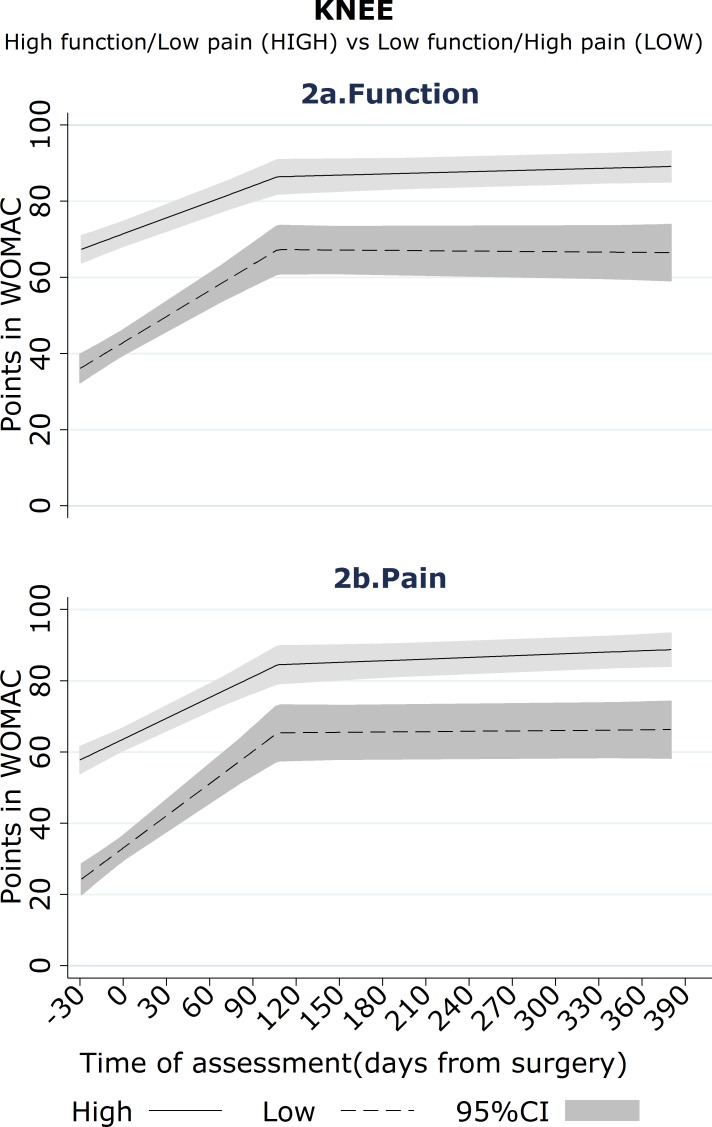
Knee -Mean trajectoriesa for WOMAC-pain and WOMAC-function (Unstandardized outcomes) by high vs. low pre-operative pain/functionb.A. The mean trajectories are derived from the fixed effects of linear mixed model stratified on high-low profile and regressing each outcome on the time of assessment parameterised as two linear splines. B. High/low function status defined on pre-operative WOMAC-function or -pain using their median scores (51 and 45) as cut-points.